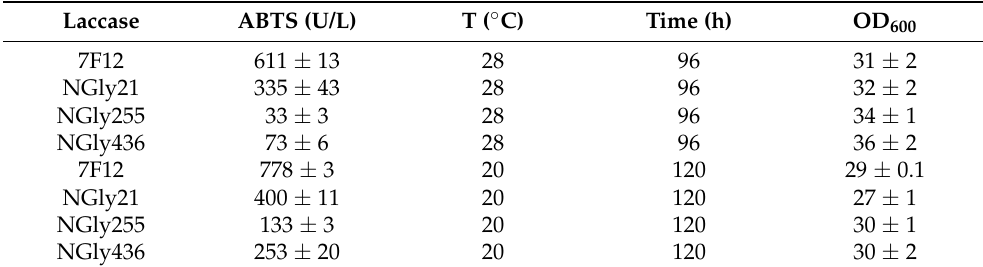
Table 7. Secreted laccase activities and OD 600 of flask liquid cultures of S. cerevisiae expressing 7F12 laccase and its N -glycosylation mutants at different temperatures (28 ◦ C and 20 ◦ C). Laccase ABTS (U/L) T ( ◦ C) Time (h) OD 600 7F12 611 ± 13 28 96 31 ± 2 NGly21 335 ± 43 28 96 32 ± 2 NGly255 33 ± 3 28 96 34 ± 1 NGly436 73 ± 6 28 96 36 ± 2 7F12 778 ± 3 20 120 29 ± 0.1 NGly21 400 ± 11 20 120 27 ± 1 NGly255 133 ± 3 20 120 30 ± 1 NGly436 253 ± 20 20 120 30 ±